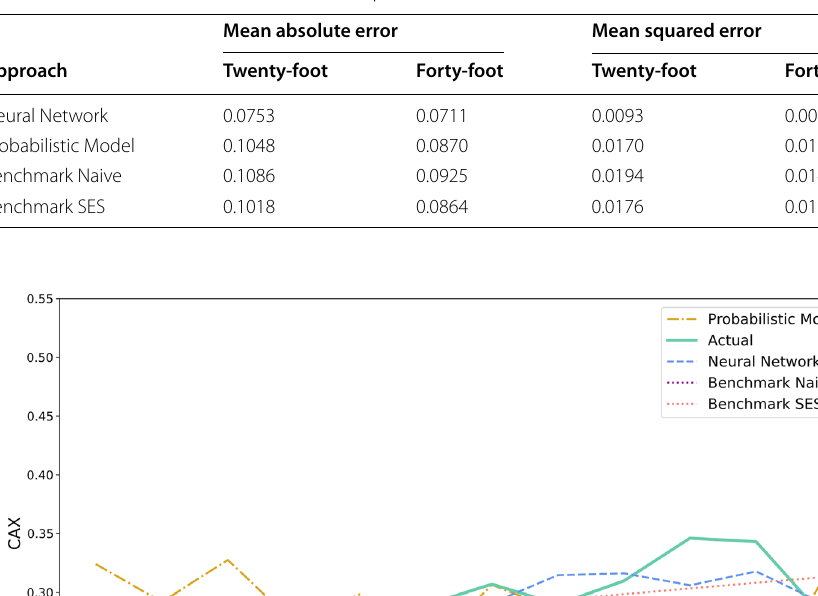
Table 3 MAE and MSE over the evaluation period. Source: Authors